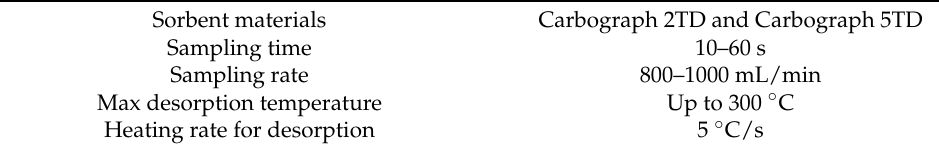
Table 1. Working parameters of the 1st stage pre-concentrator.